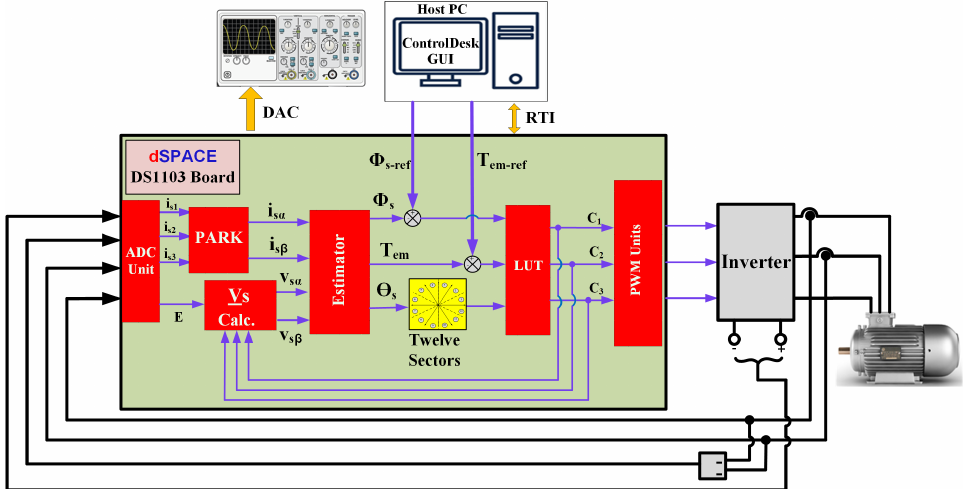
Figure 20. Practical block diagram of the experimental